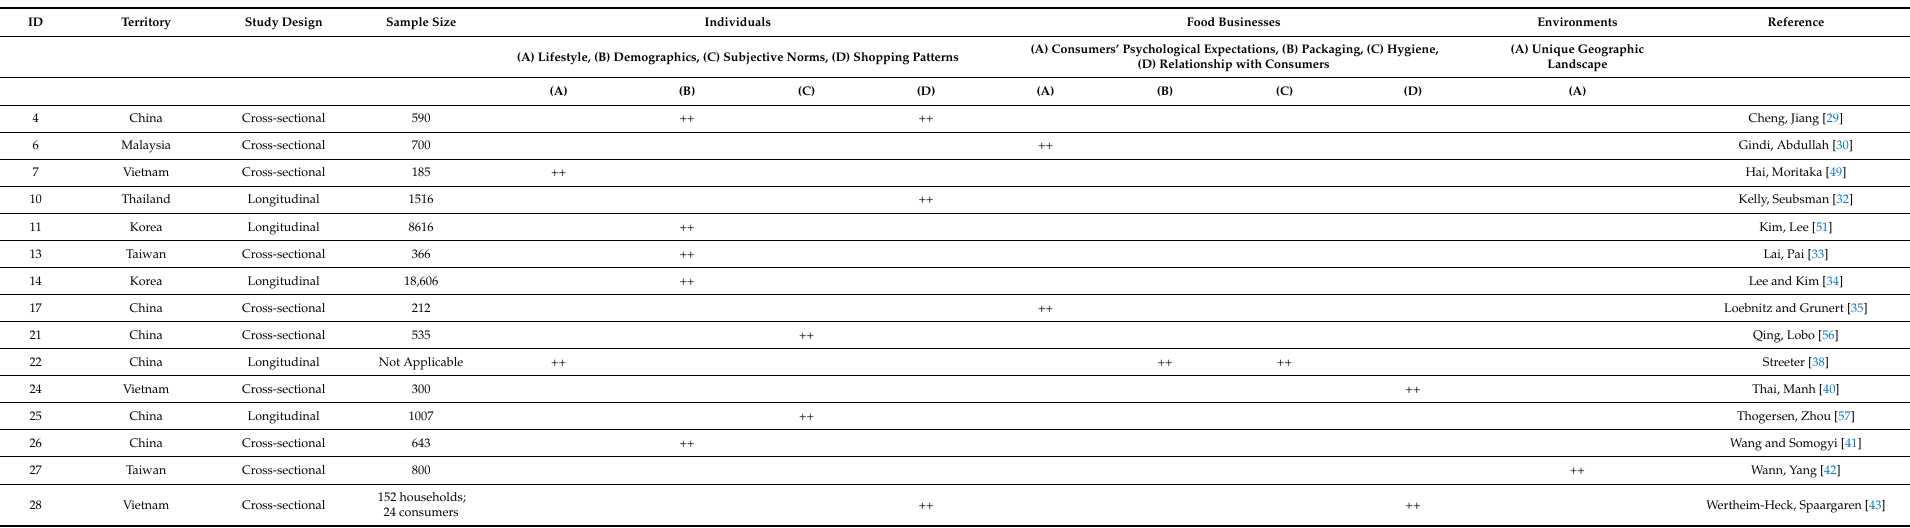
Table 5. Moderators to FV consumption in East and Southeast